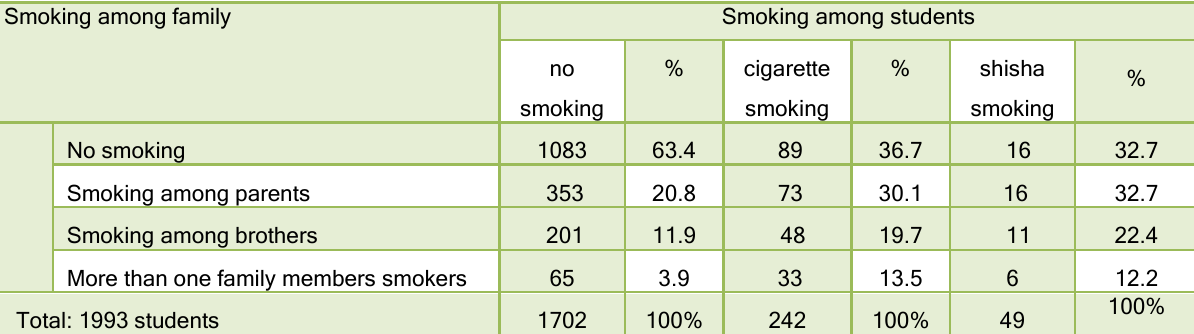
Table (3):The effect of smoking among family on the prevalence of smoking among students. Smoking among family